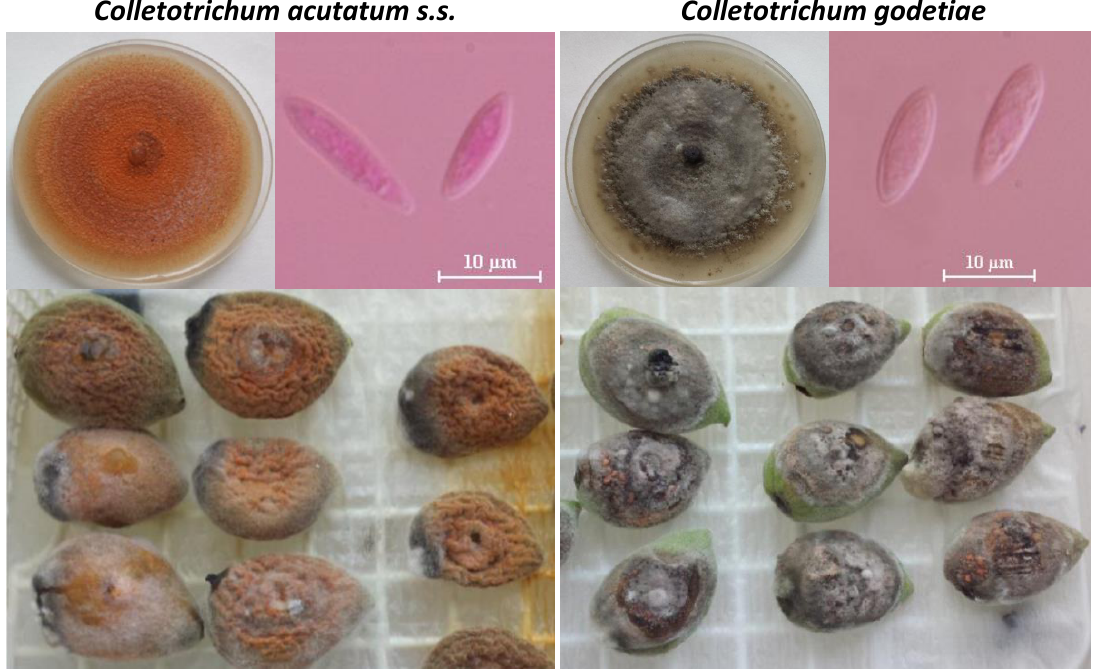
Figure 2. Colonies and conidia of Colletotrichum acutatum s.s. (isolate Col-506; pink–orange subpopulation) and C. godetiae (isolate Col-522; gray subpopulation) identified as causal agents of almond anthracnose in Southern Spain. Colonies grown on PDA and on inoculated almond fruits at 23 ± 2 ◦ C with a 12-h photoperiod for 7 and 14 days, respectively. Scale bars: (conidia) 10 µ